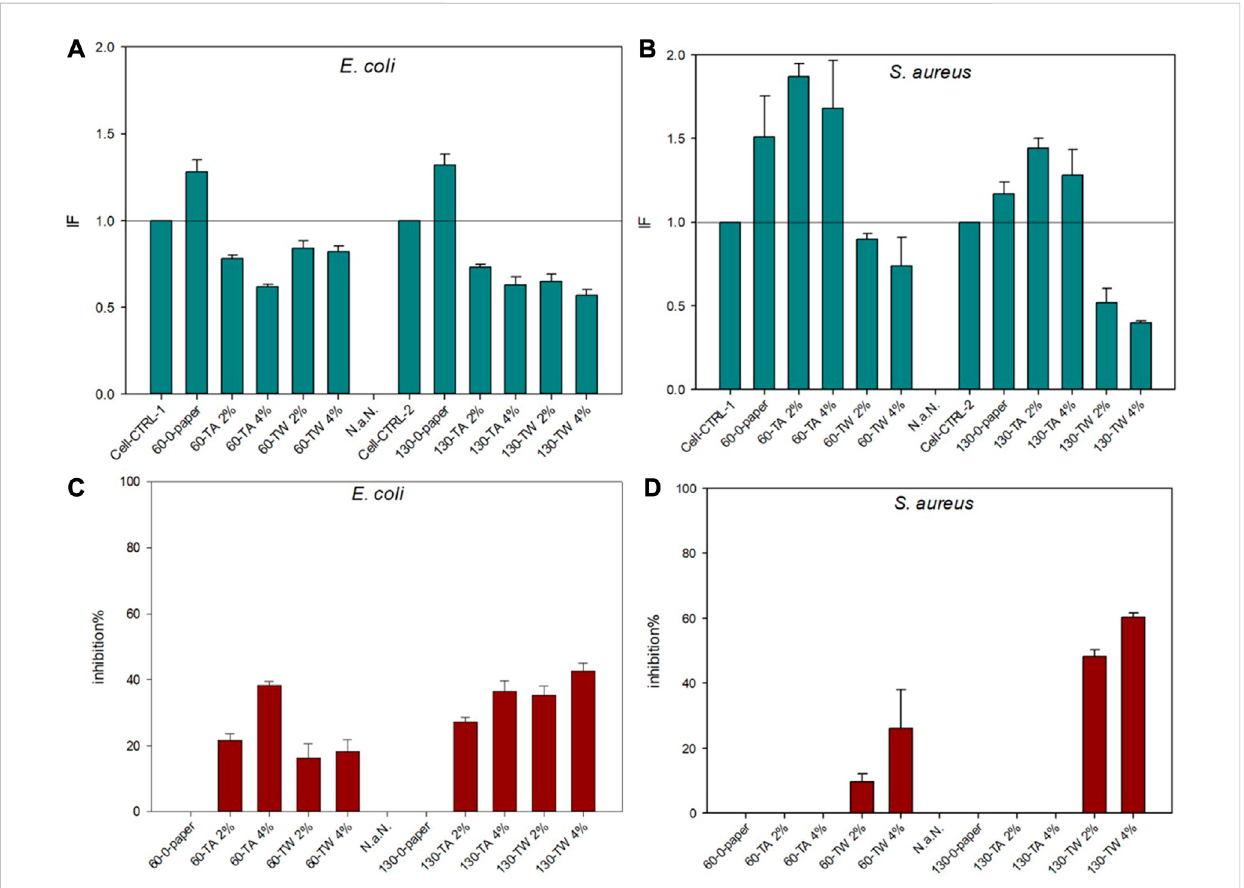
Bacterial imaging results in impact factors (IF) with E. coli (A) and S. aureus (B) and in inhibition% with E. coli (C) and S. aureus (D) for both paper thicknesses 60 g/m 2 (60) and 130 g/m 2 (130) and TW extract (TW) and tannic acid (TA) in two different doses 2% and 4%. The horizontal line in (A) and (B) indicatesthelevelofimpactfactor(IF=1)wherenoantibacterialeffectisdetected.Valuesbelowthehorizontalline(IF=1)indicateantibacterialeffectsby a decrease in luminescent light production, and values above indicate an increase in luminescence production. The error bars show the standard deviation of three replicates in separate Petri dishes. TA-enriched sheets create a clear inhibition zone in the S. aureus plates (Figure 6) but the light production is substantially increased at the zone border (Figure 7) likely because the killed bacterial cells provide nutrition to the survived